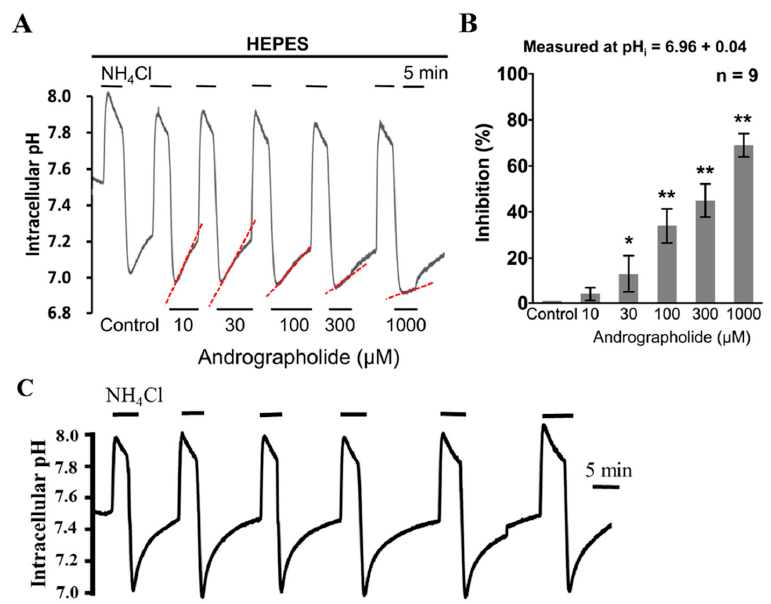
Figure 4. Effect of acute treatment with Andrographolide on intracellular pH (pH i ) recovery rate in HEPES-buffered solution. ( A , C ) The top bar shows the buffer system used, and the bars above and below the trace show the period of acute application of NH 4 Cl and Andrographolide (10–1000 µ M), respectively. The most left and right traces show the typical NH 4 Cl prepulse technique as a control and wash, respectively. ( B ) Histograms show the normalization of change on pH i recovery rate after acute application of Andrographolide (10–1000 μ M) in HEPES-buffered condition, respectively. The pH i recovery rate measured is shown at the top of the histogram, and * p < 0.05 and ** p < 0.005 versus the control. Error bars represent the mean ± SEM (standard error mean).